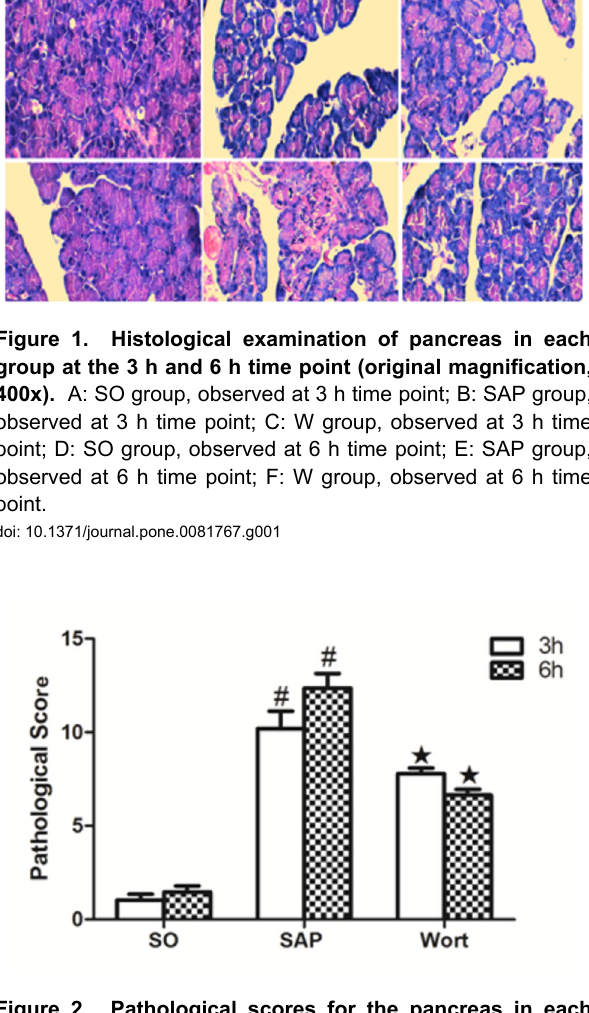
Figure 2. Pathological scores for the pancreas in each group at the 3 h and 6 h time point. # P <0.05 vs. SO group; ★ P <0.05 vs. SAP group.